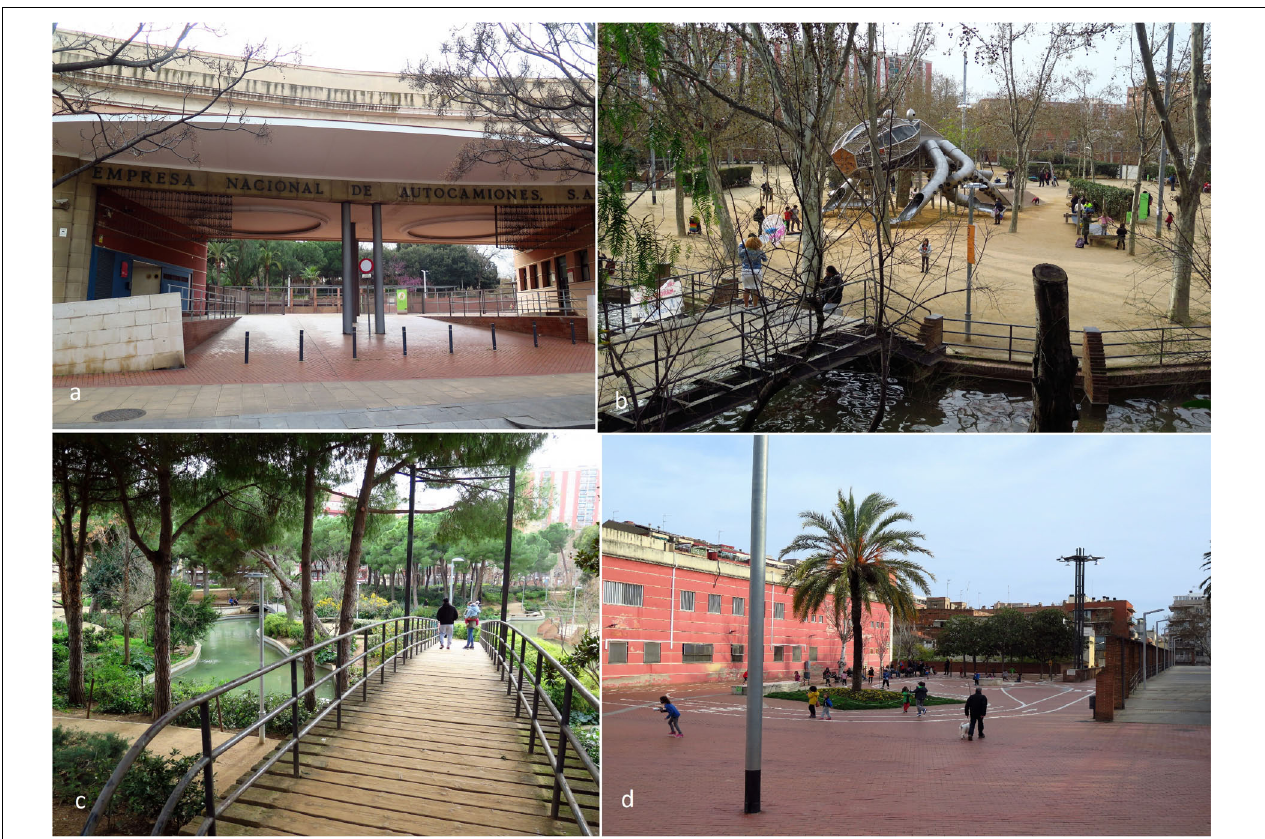
FIGURE 3 | Pegaso Park, (a) Main entrance of the park, preserving the original access to the factory; (b) The lake surrounding the playground area in the esplanade; (c) Bridges, paths, and canal flowing to the lake; and (d) Paved playing area serving as a transition between the main entrance and the green areas. Source: